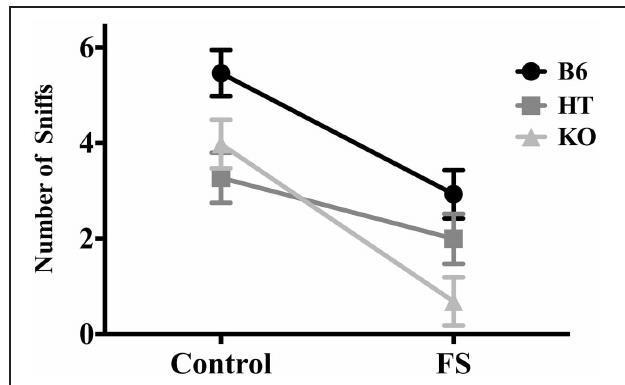
FIGURE 3 | Number of sniffs to the almond slice made by wild-type C57BL/6J (B6), heterozygous (HT), and β -E knock-out (KO) mice during the 5-min NSF test. Data show mean ± SE. ANOVA and post-hoc analysis (Fisher’s LSD test) indicated that forced swim exposure decreased almond sniffing, and a main effect of genotype reflected the fact that B6s sniffed the almond more than either of the other two lines, which did not differ from each other ( p -values ≤ 0.05). There were no significant interaction effects of genotype and condition on number of sniffs.